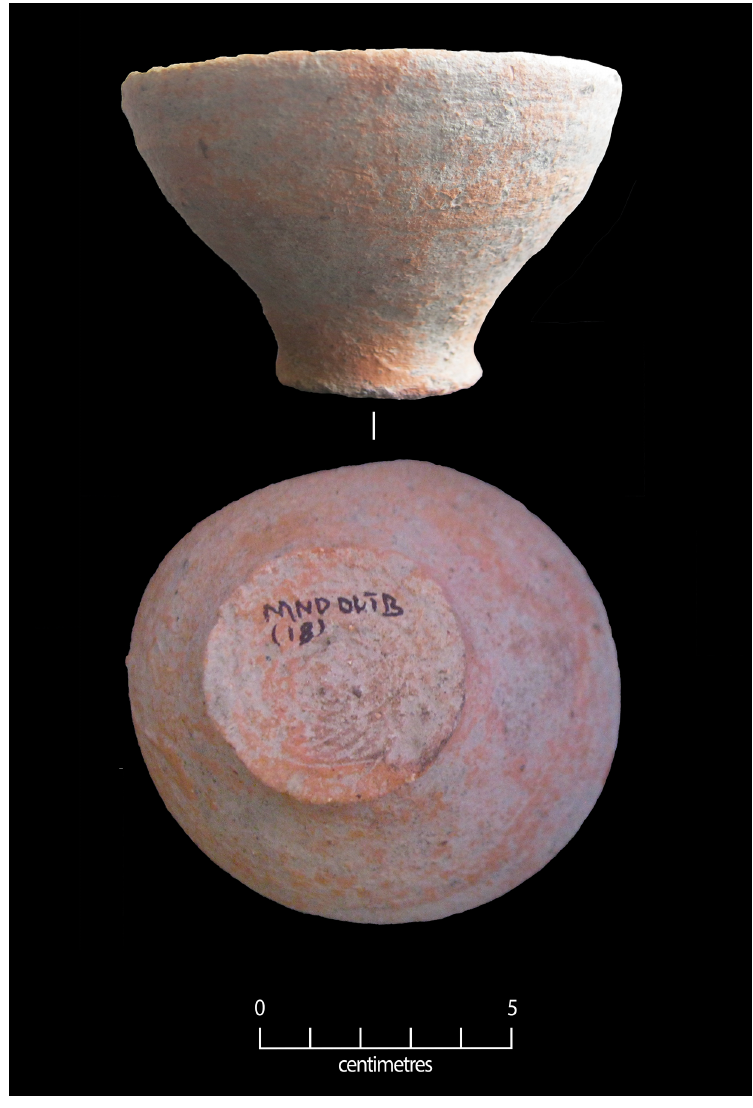
Figure 34: External surfaces (profile and base) of a Class 11